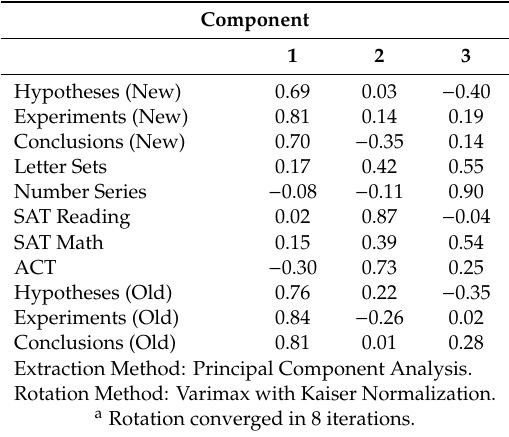
Table 7. Study 1 Rotated Principal-Components Matrix: Complete Set of Measures a .